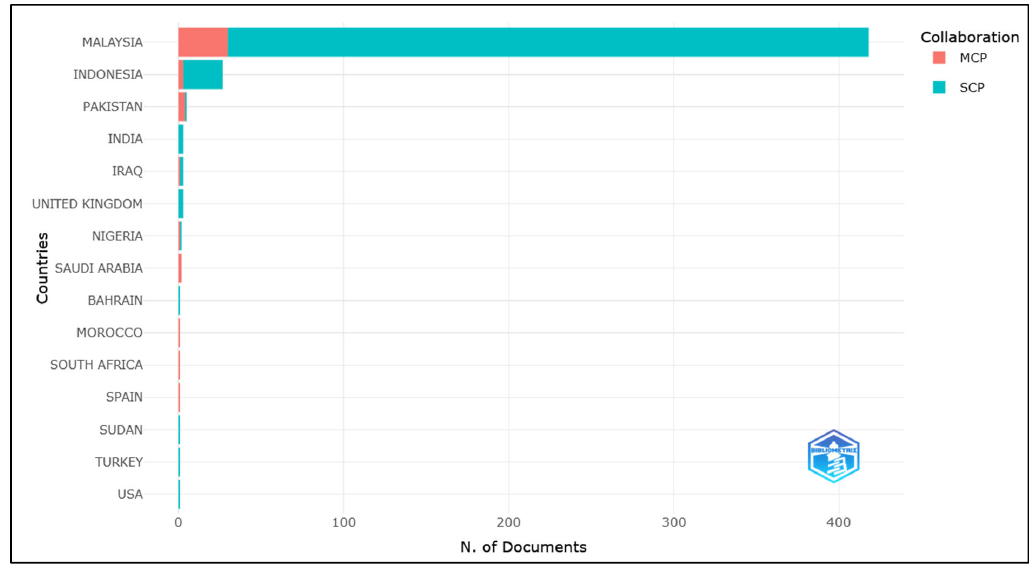
Figure 3. Corresponding author’s country.